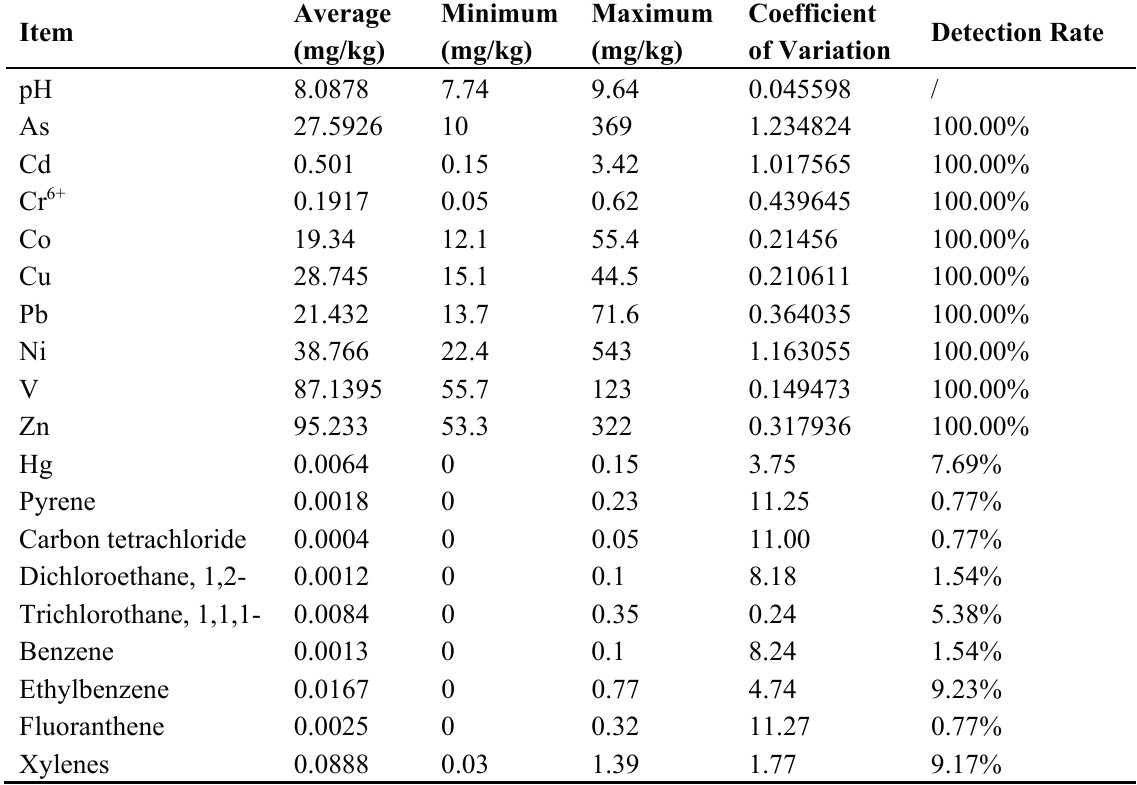
Table 3. Overview of soil